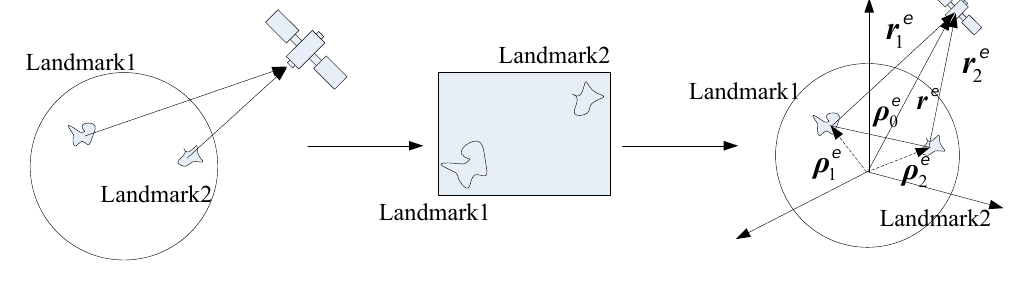
Figure 1. Acquisition process of